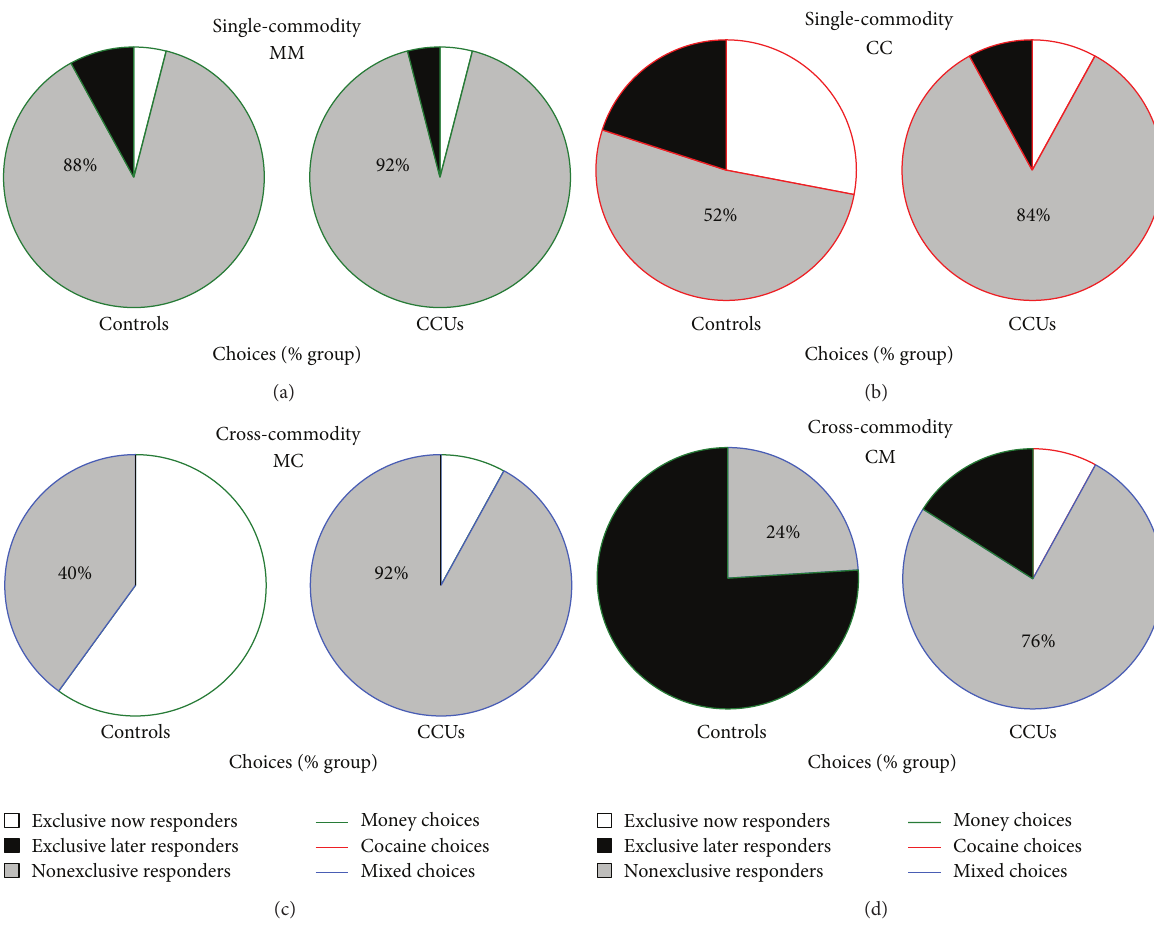
Figure 2: Choice behavior. Pie charts are of the proportion of each group who were exclusive (only chose immediate or delayed options) or nonexclusive (chose both immediate and delayed options) responders in each task. In single-commodity tasks individuals chose between immediate or delayed money (MM, (a)) or cocaine (CC, (b)). In cross-commodity tasks individuals chose between immediate money or delayed cocaine (MC, (c)) or between immediate cocaine or delayed money (CM, (d)). Based on choice behaviors individuals were included in two analysis streams. In the first analysis stream, nonexclusive responders (percentages displayed) were included in a temporal discounting behavioral analysis. Indifference points based on behavioral choice could not be calculated for exclusive responders, so these individuals were excluded. In the second analysis stream, all individuals (exclusive and nonexclusive responders) were included in a behavioral analysis examining all immediate and delayed choices. Exclusive responders were included according to the commodity they always chose. This analysis determined the individuals to be included in imaging analyses of immediate and delayed choices for each